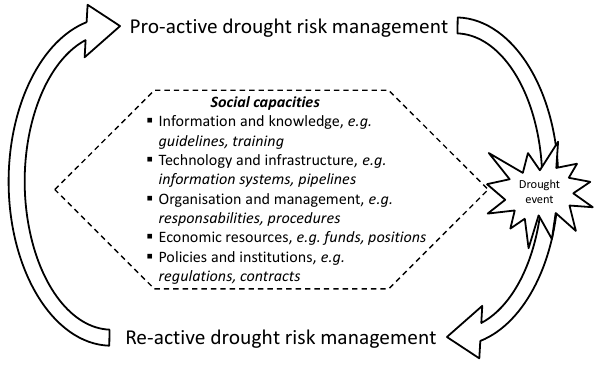
Fig. 1. General social capacities for drought risk